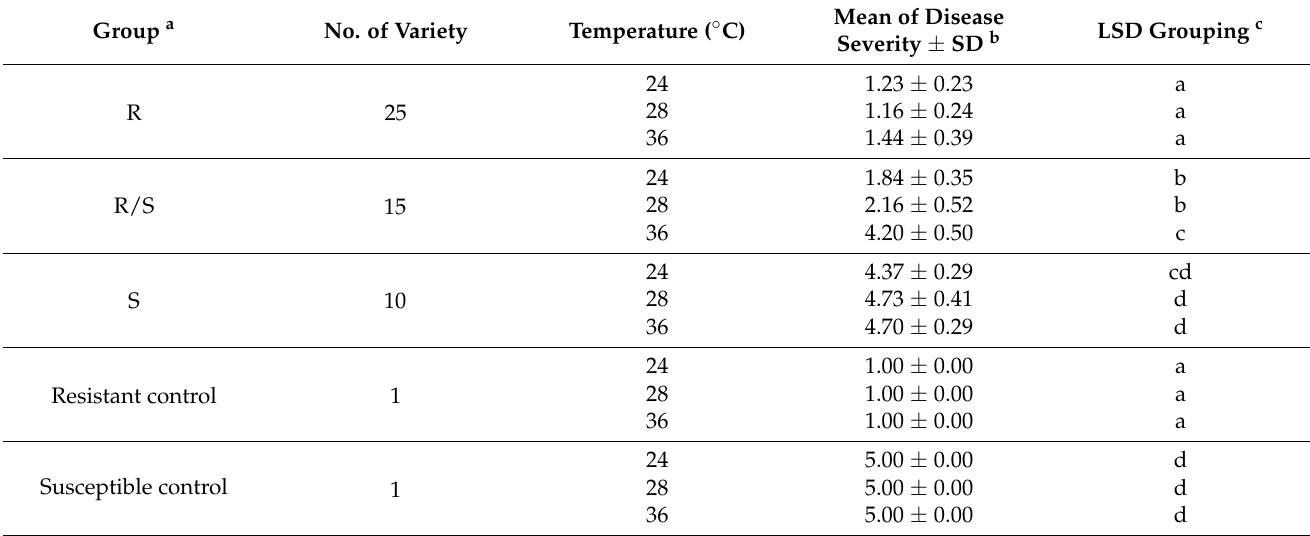
Table 1. The seedling assay of bacterial wilt disease at three different ambient temperatures in 50 tomato varieties and controls.